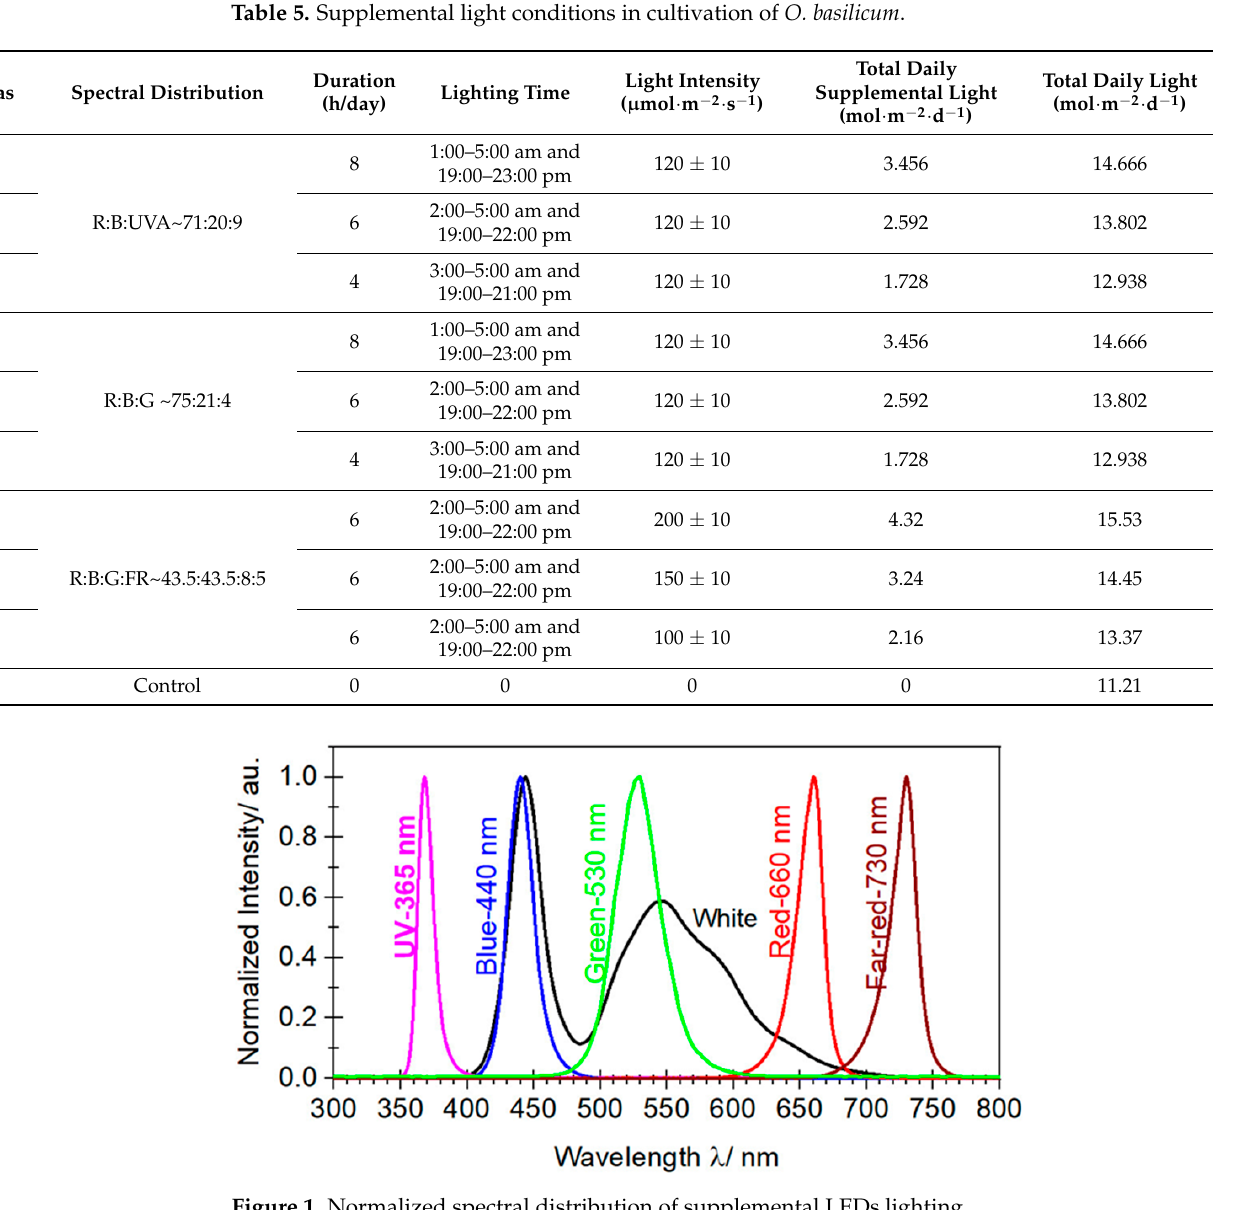
Table 5. Supplemental light conditions in cultivation of O. basilicum.